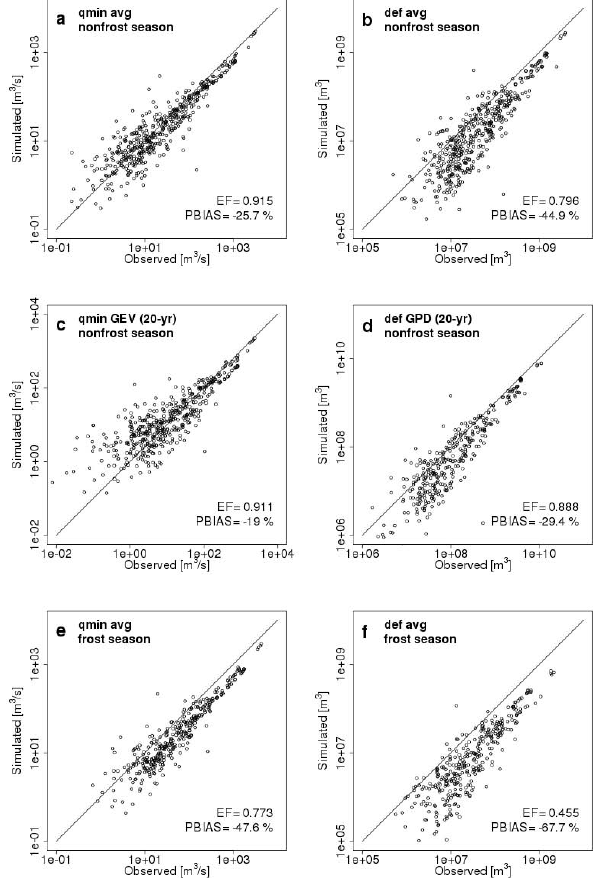
Fig. 3. Observed versus ensemble-averaged simulated streamflow drought indices for the control period (1961–1990) at each of the 446 stations depicted in Fig. 1.